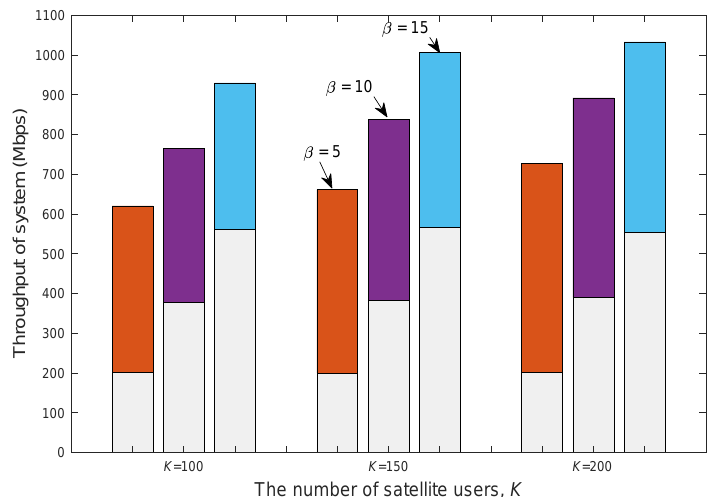
Figure 7. Throughput of different systems with different numbers of terrestrial base stations (BSs) versus satellite user numbers. The lower part and upper part of each bar correspond to the throughputs of terrestrial and satellite communications, respectively (under the FFR pattern with CR, N t = 256 and N g =